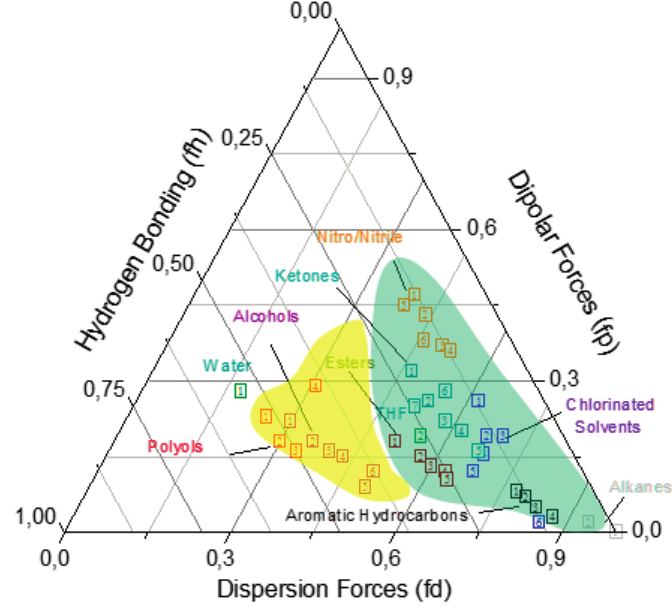
Figure 1. Teas Chart showing the solubility of TIPS-pentacene in common solvent